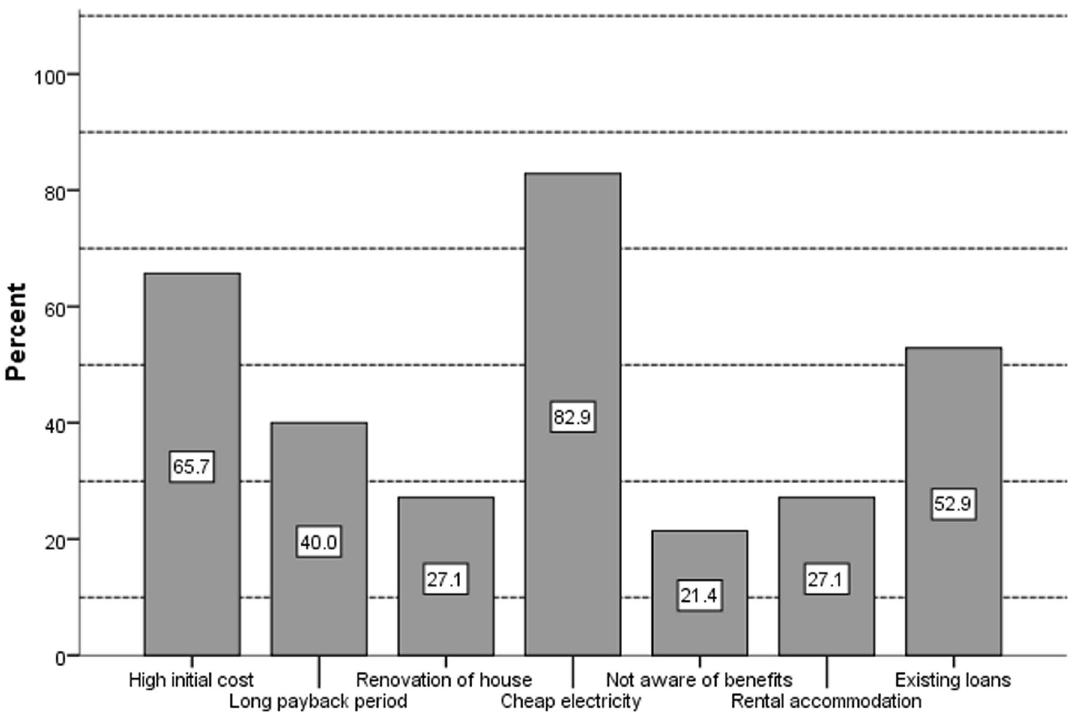
Fig. 2 Reasons cited as barriers among the 70 surveyed households that didn’t adopt PV. Note: multiple response question (% >